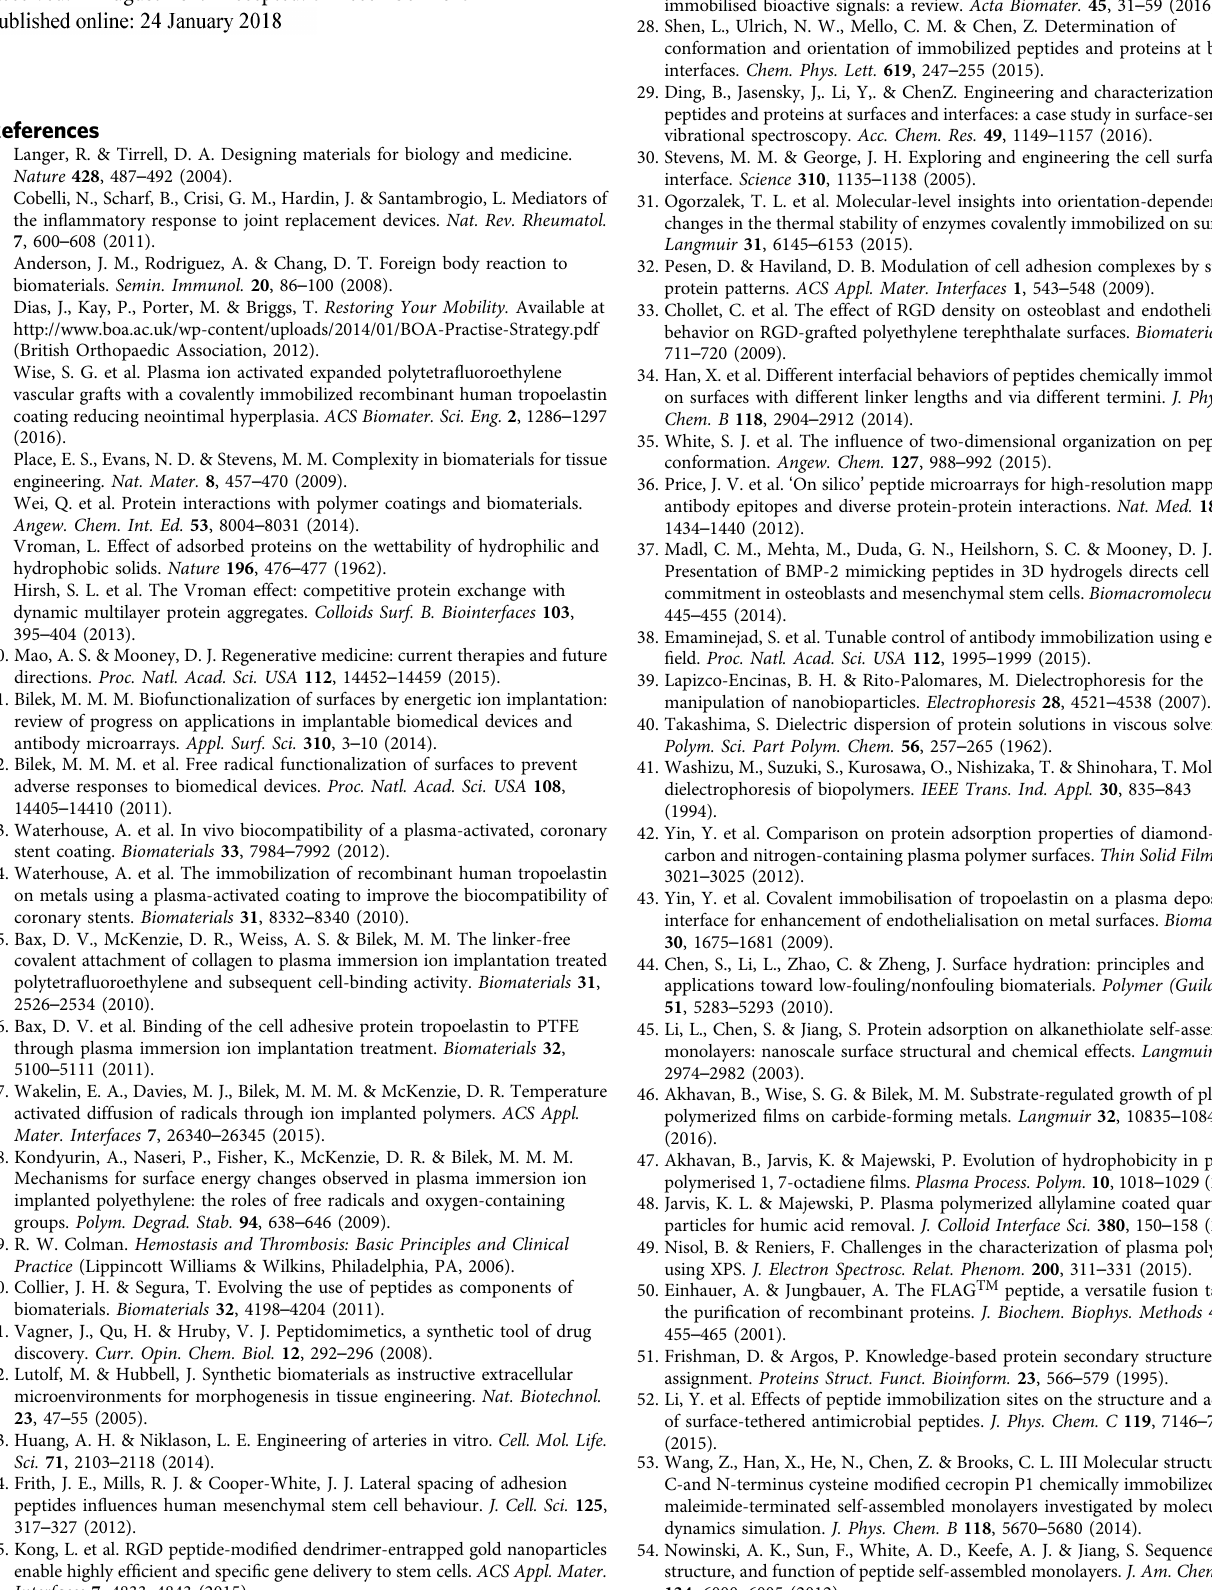
from the corresponding authors upon